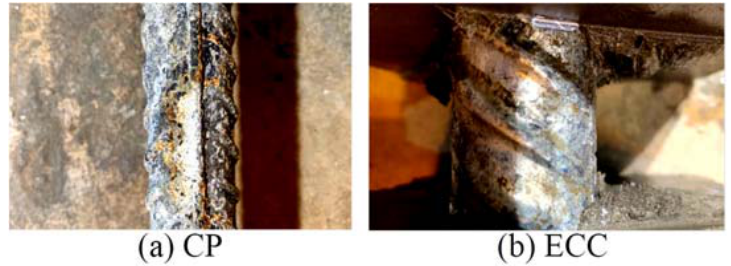
Figure 9. Corrosion phenomenon of CP and ECC specimens after the impressed current test.